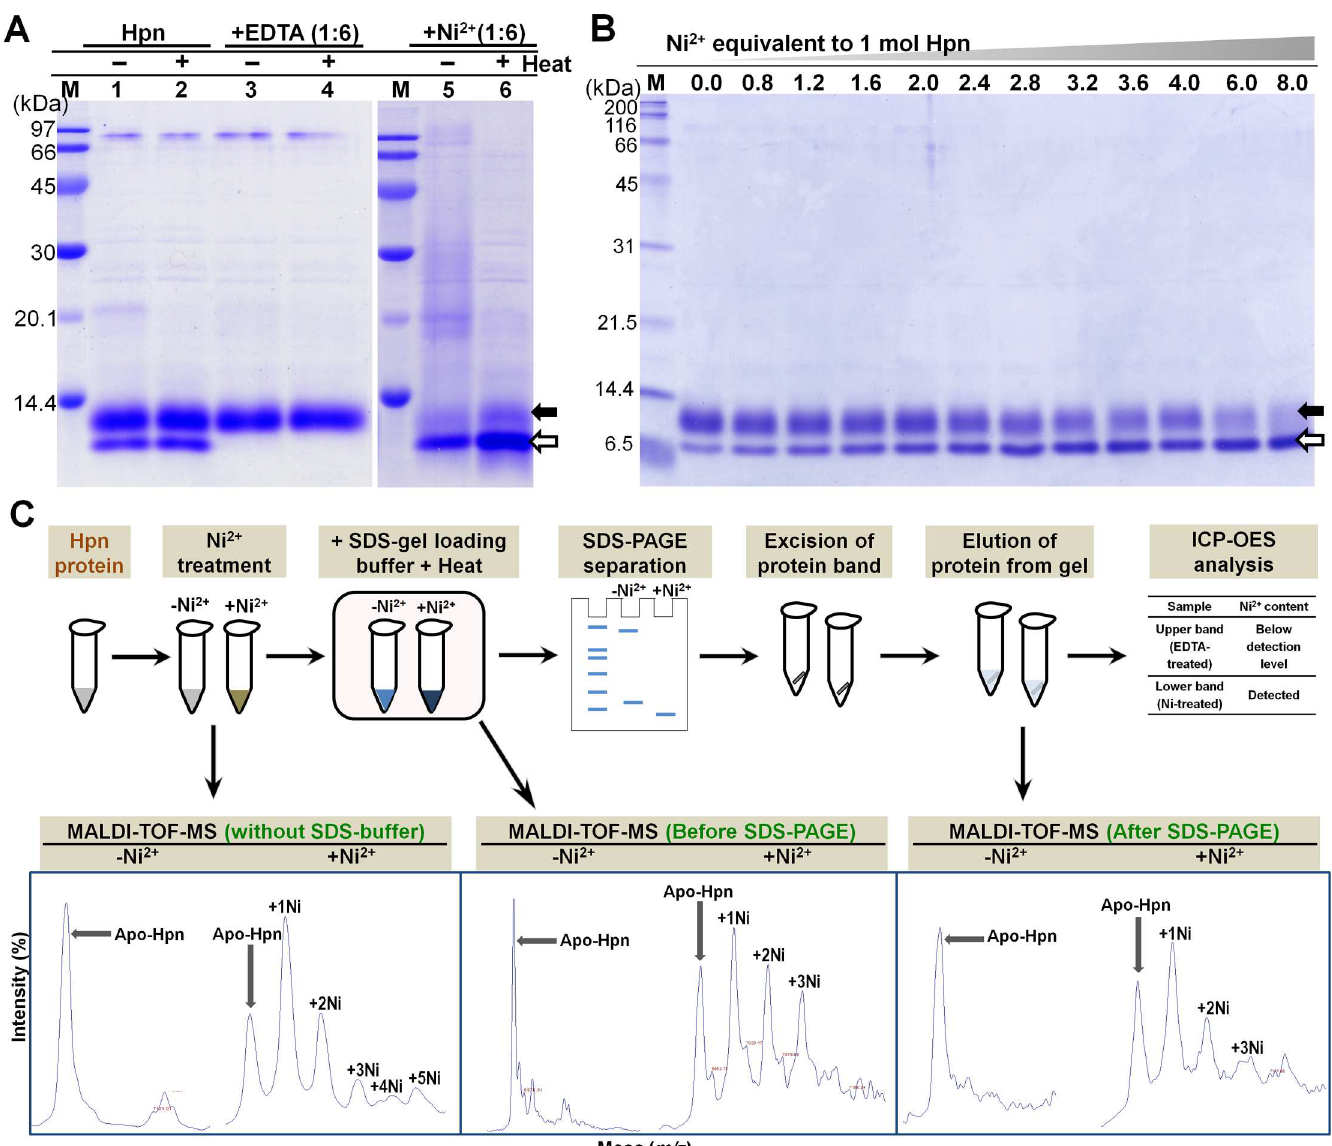
Fig 3. Confirmation of “Metal gel-shift” mechanism. A. Effect of EDTA and Ni 2+ ion treatment on migrationrate of recombinant Hpn in SDS-PAGE (polyacrylamide-gel 20%). Lane M, protein marker (GE Healthcare; MW from top to bottom: 97, 66, 45, 30, 20.1 and 14.4 kDa); lane 1 and 2, Hpn before and after boiling(3 min at 100˚C), respectively; lanes 3 and 4, EDTA-treated Hpn without and with boiling,respectively;lanes 5 and 6, Ni 2+ -treated Hpn without and with boiling,respectively. B. The SDS-PAGE analysisof partially-metalated-Hpn (25 μ M) treated with increasingconcentration of Ni 2+ (1:0, 1:0.8, 1:1.2, 1:1.6, 1:2.0, 1:2.4, 1:2.8, 1:3.2, 1:3.6, 1:4.0, 1:6.0 and 1:8.0). Lane M is marker proteinsstandard from NacalaiTesque (200, 116, 66, 45, 31, 21.5, 14.4, 6.5 kDa from top to bottom respectively). Equal volume of heat-denaturedprotein appliedin each lane. C. Scheme used for